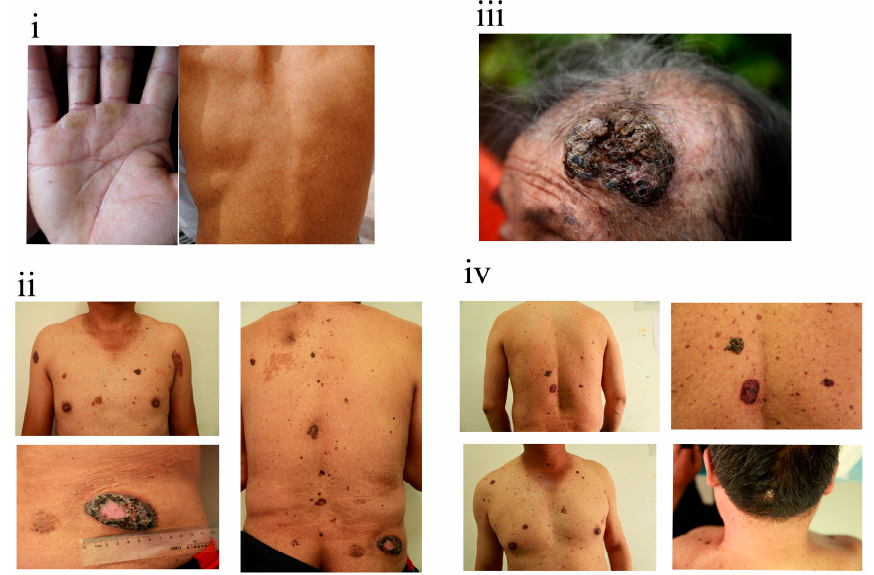
Figure 3. Clinical appearances of family members “N” ( i ); “G” ( ii ); “B” ( iii ) and “E” ( iv ).